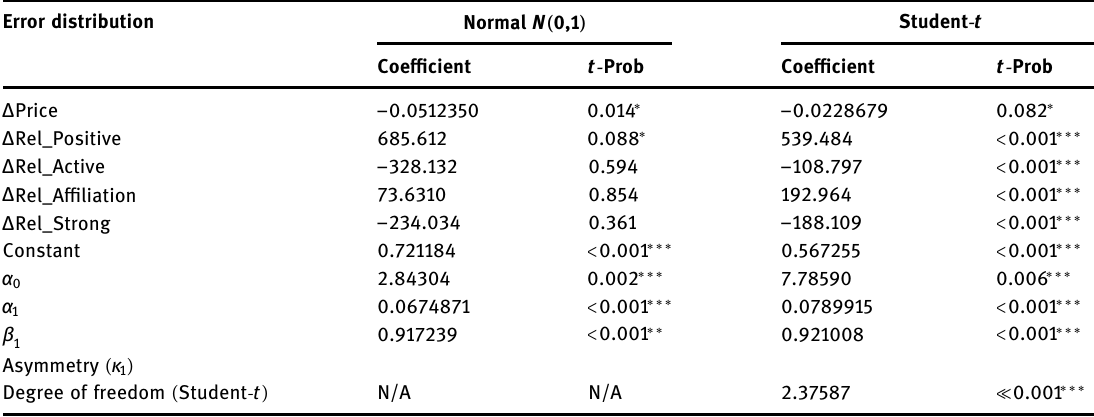
Table 5: AGARCH model for S&P500